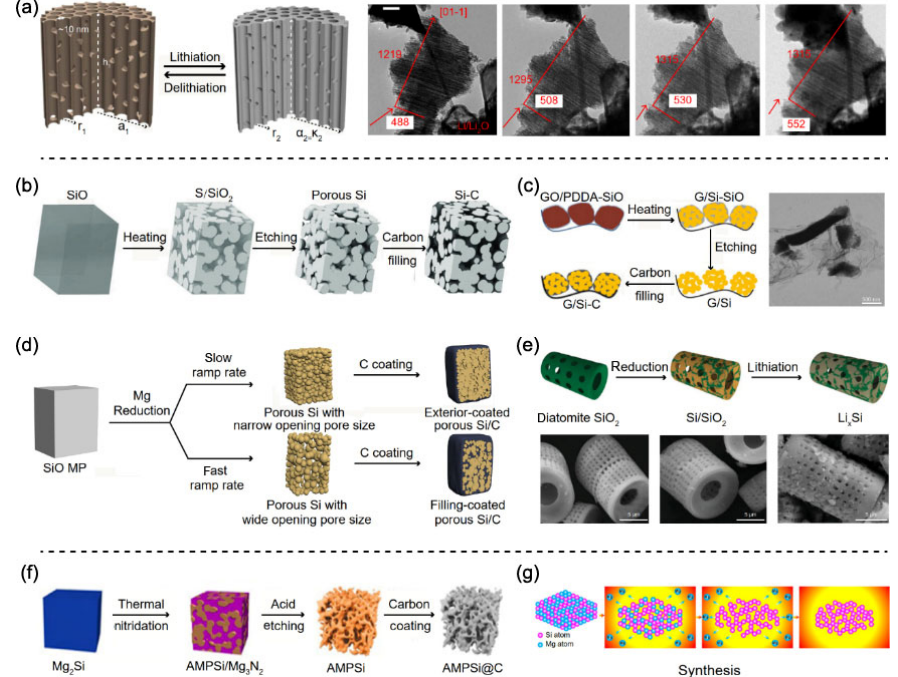
Figure 4 Synthesis of μ-porous-Si. (a) A schematic model of the MSS particle. Reproduced with permission from Ref. [66], © Macmillan Publishers Limited 2014. (b) Preparation process from the SiO precursor to the Si-C composite. Reproduced with permission from Ref. [74], © WILEY-VCH Verlag GmbH & Co. KGaA, Weinheim 2013. (c) Preparation process of G/Si–C. Reproduced with permission from Ref. [76], © WILEY-VCH Verlag GmbH & Co. KGaA, Weinheim 2013. (d) Fabrication of carbon-coated Si/C microparticles. Reproduced with permission from Ref. [77], © Elsevier Ltd. 2017. (e) Schematic illustration of diatomite SiO 2 , diatomite-derived Si/SiO 2 , lithiated Si, and SEM image of diatomite SiO 2 . Reproduced with permission from Ref. [78], © Wiley-VCH GmbH 2020. (f) Schematic showing the preparation of ant-nest-like microscale porous Si (AMPSi) and AMPSi@C. Reproduced with permission from Ref. [79], © An, W. L., et al. 2019. (g) Schematic of the evolution of Mg 2 Si alloy by the vacuum distillation method. Reproduced with permission from Ref. [80], © American Chemical Society